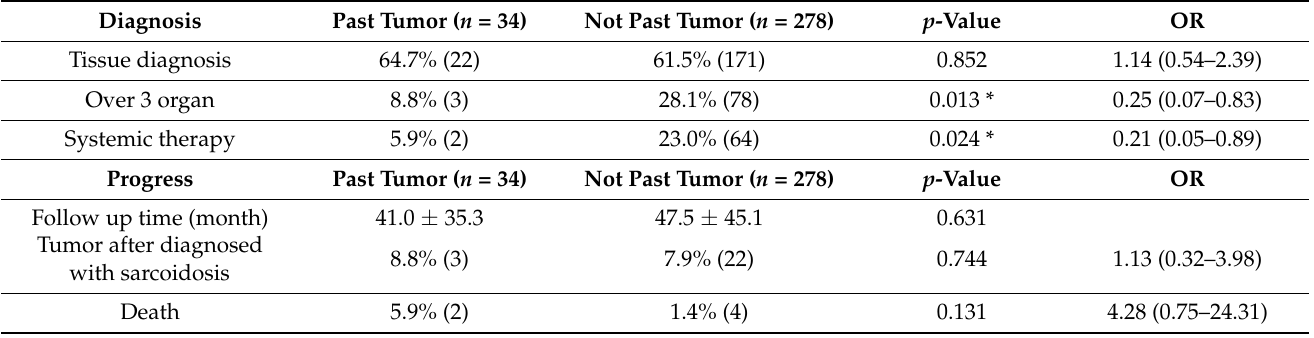
Table 7. Number of affected organs (>3) and frequency of systemic therapy with or without tumor